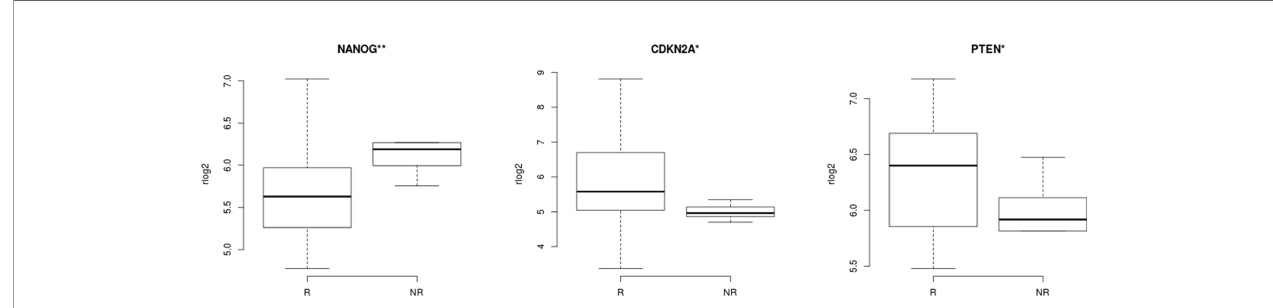
FIGURE 4 | Correlation of stemness features in cervical cancer stem-like cells and response to therapy. CCSCs expression levels of genes related to stemness in cancer revealed three transcripts with statistically signi fi cant differences between Non-Responder (n=10) compared to Responder patients (n=21). CDKN2A (p=0.038), NANOG (p=0.006), PTEN (p=0.048), Wilcoxon rank-sum test.